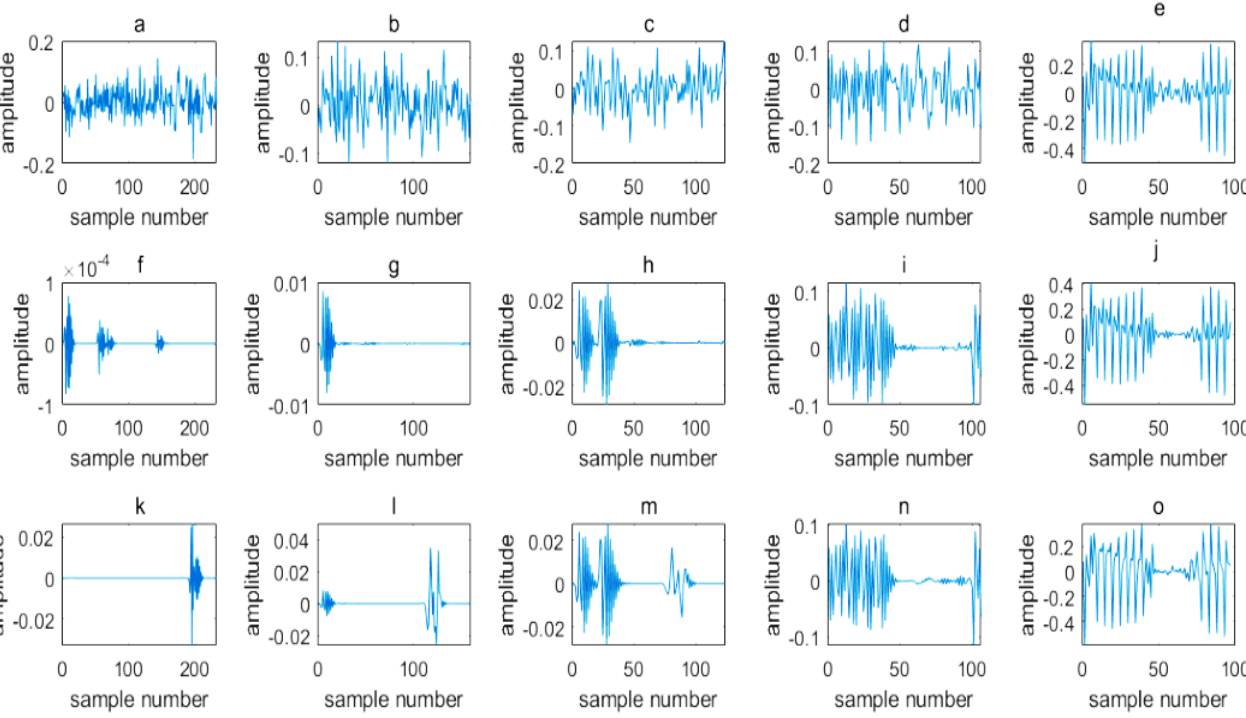
Figure 7. (a-e) 5 level noisy signal details, (f-j) 5 level original signal details and (k-o) 5 level denoised signal